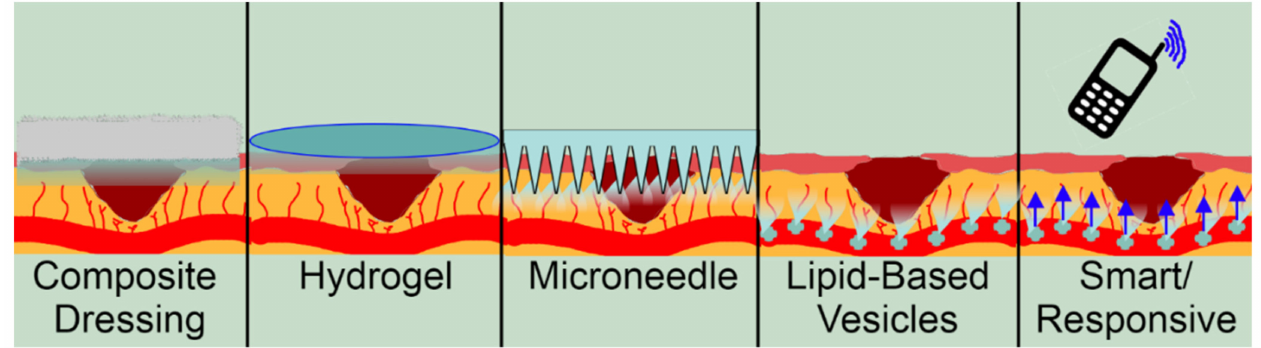
Figure 3. Modern delivery methods applied to natural products to improve their delivery and